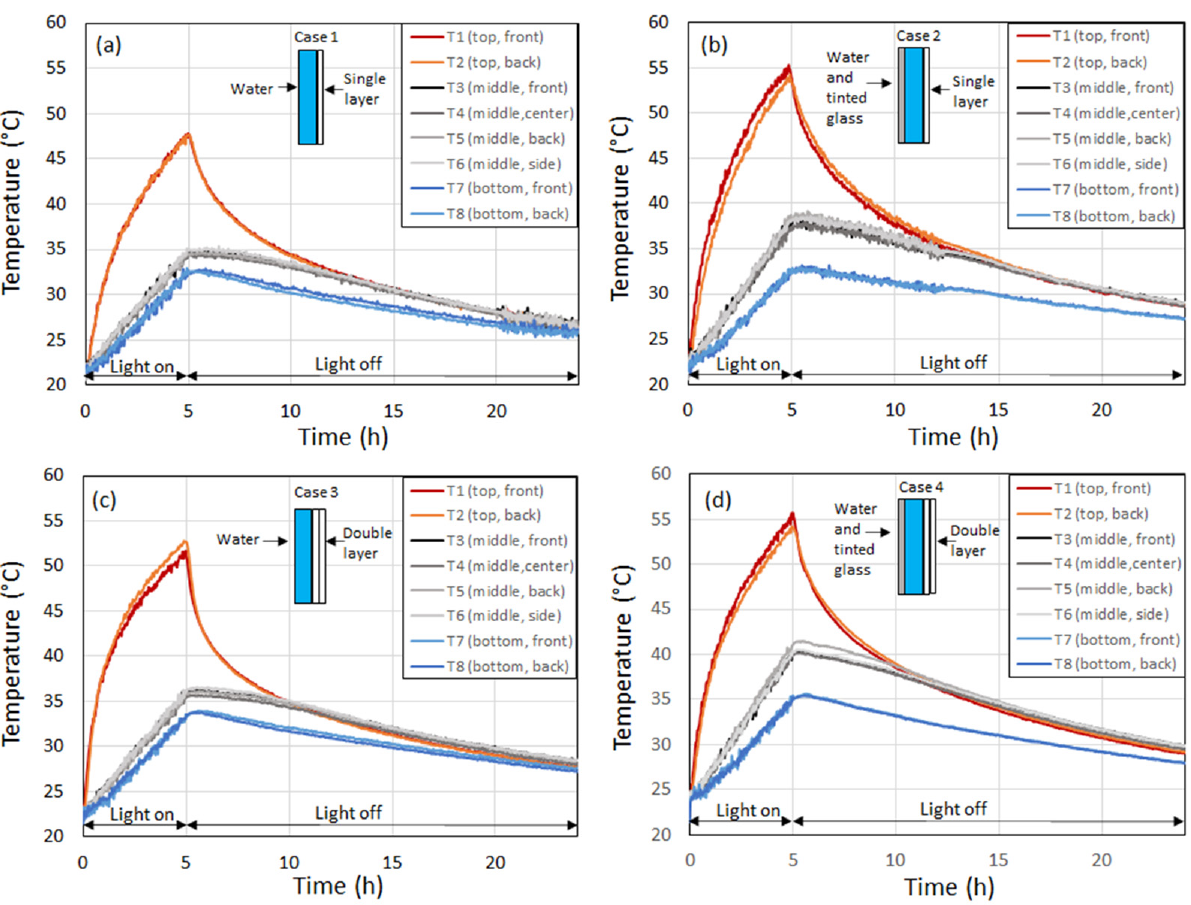
Figure 4. Temperature profiles throughout the Trombe wall prototype in ( a ) Case 1, ( b ) Case 2, ( c ) Case 3 and ( d ) Case 4 (The thermal storage medium for the different cases is described in Table 1 and are shown in the insets in this figure).